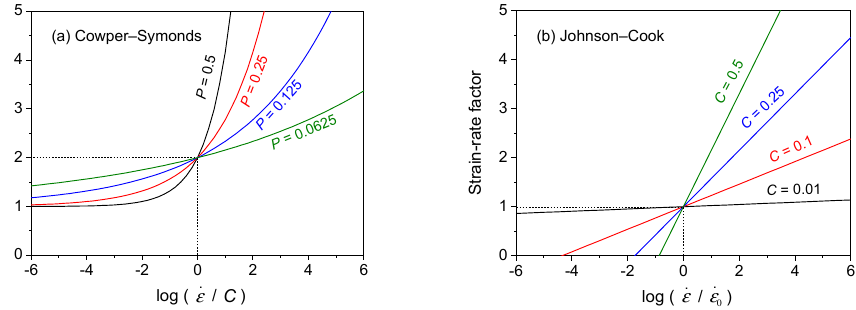
. ε / C ) and ( b ) Johnson–Cook rate